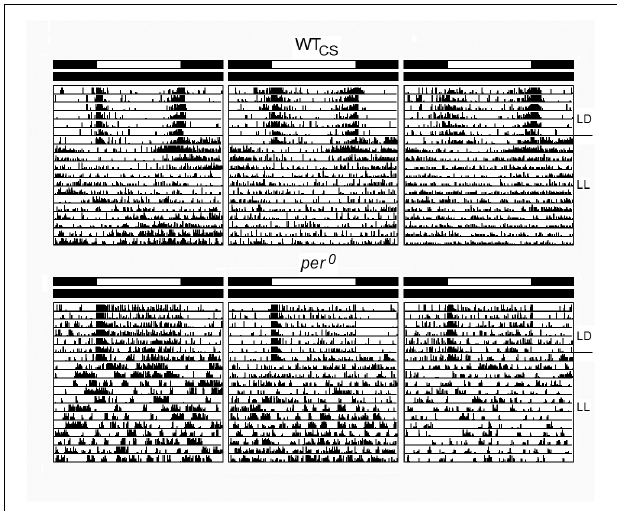
FIGURE 5 | Typical actograms of wildtype flies (WT CS ) and per 0 mutants under LD and constant light (LL). For both strains three individual actograms are selected that revealed the strongest rhythmicity under LL. Of 32 recorded wildtype flies 6 revealed weak rhythms with a mean period of 26.0 ± 0.6 h (SEM). The other flies were arrhythmic. In per 0 mutants, periodogram analysis found weak rhythms in 5 of 32 flies. These had a mean period of 25.0 ± 1.4 h (SEM). All other flies were